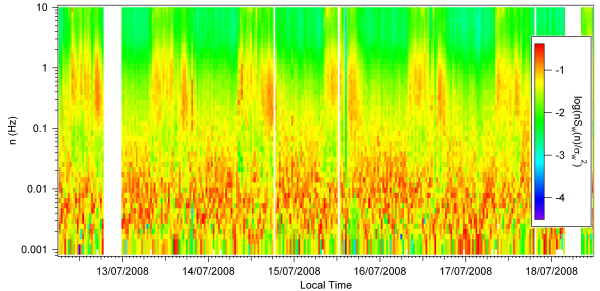
Fig. 13. A time-series of the frequency weighted power spectra of w